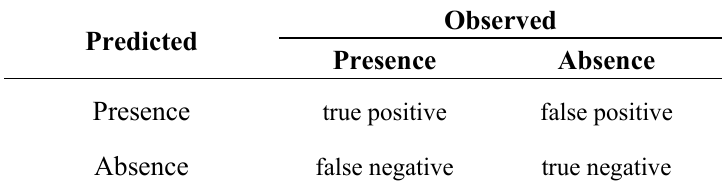
Table 2. An error matrix used to evaluate the predictive accuracy of models.